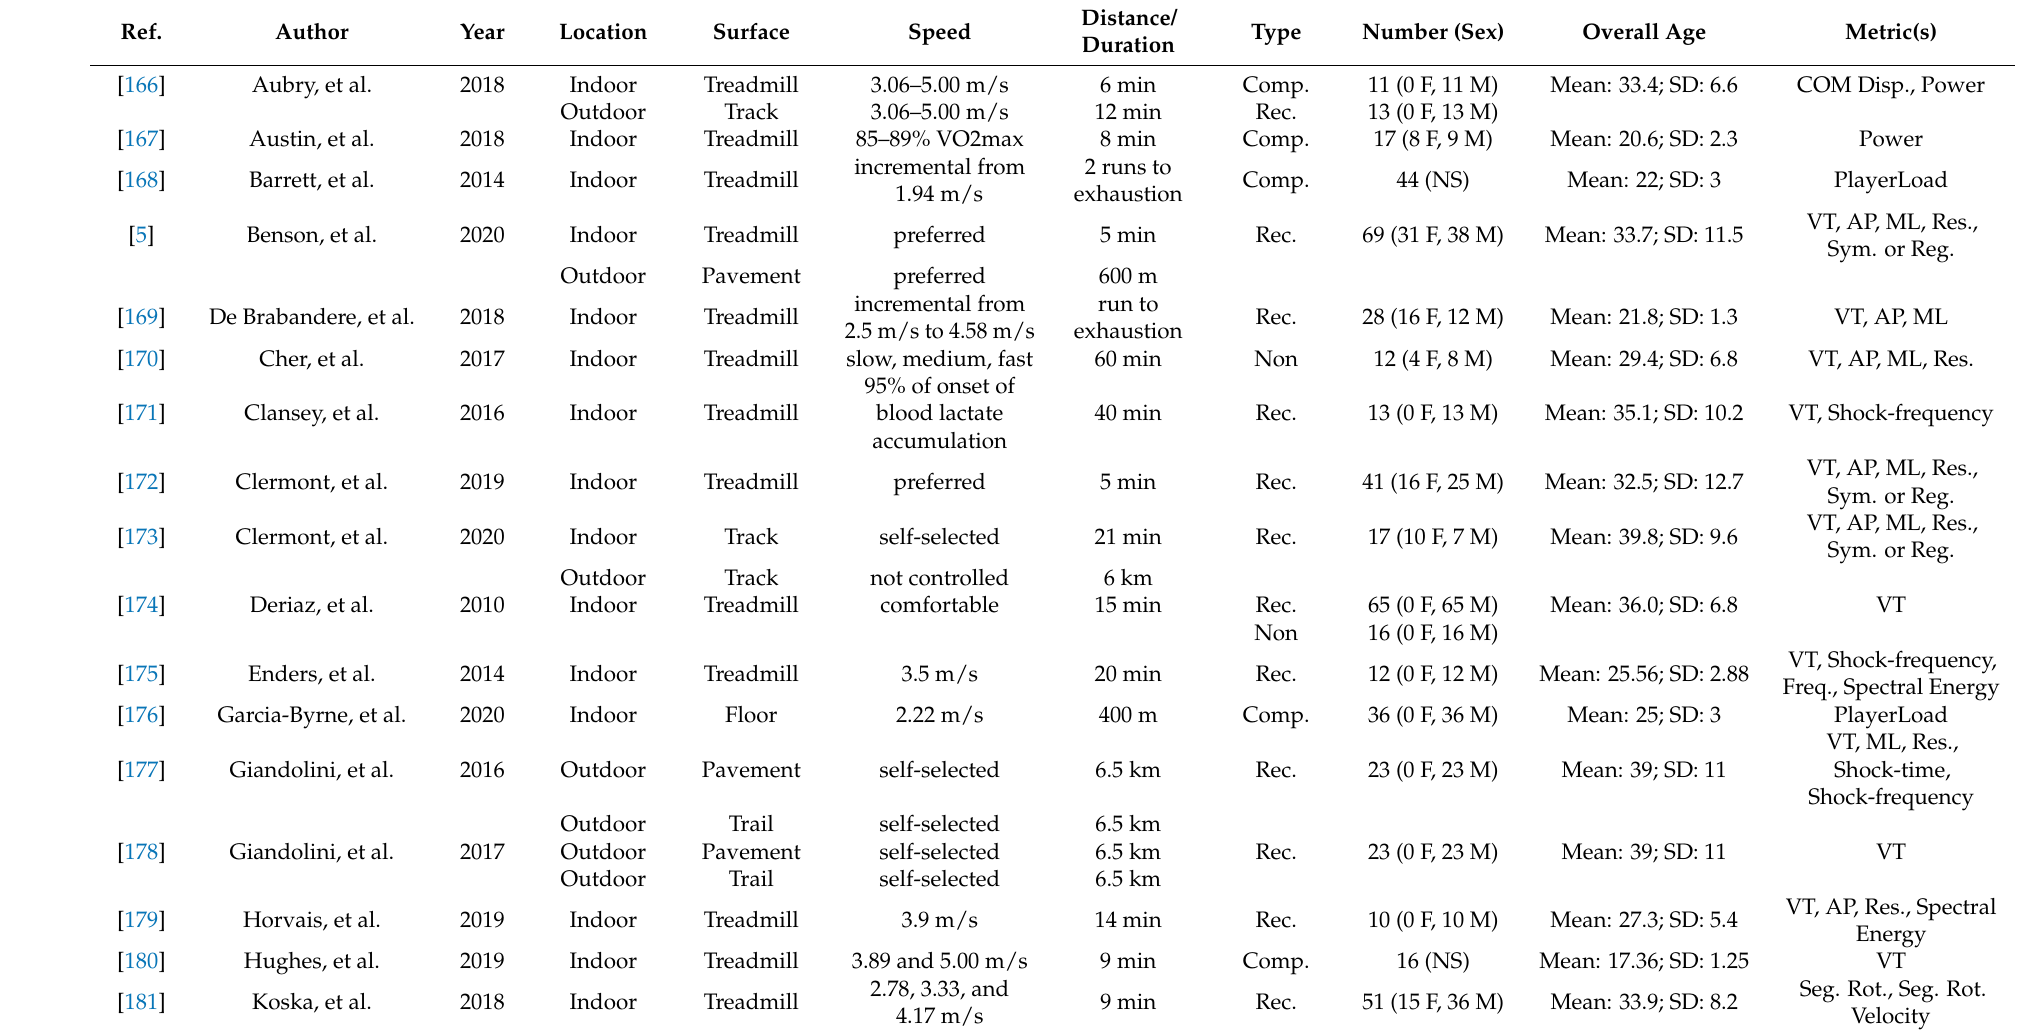
Table 3. Study characteristics where the analyzed distance is 200–1000 m.